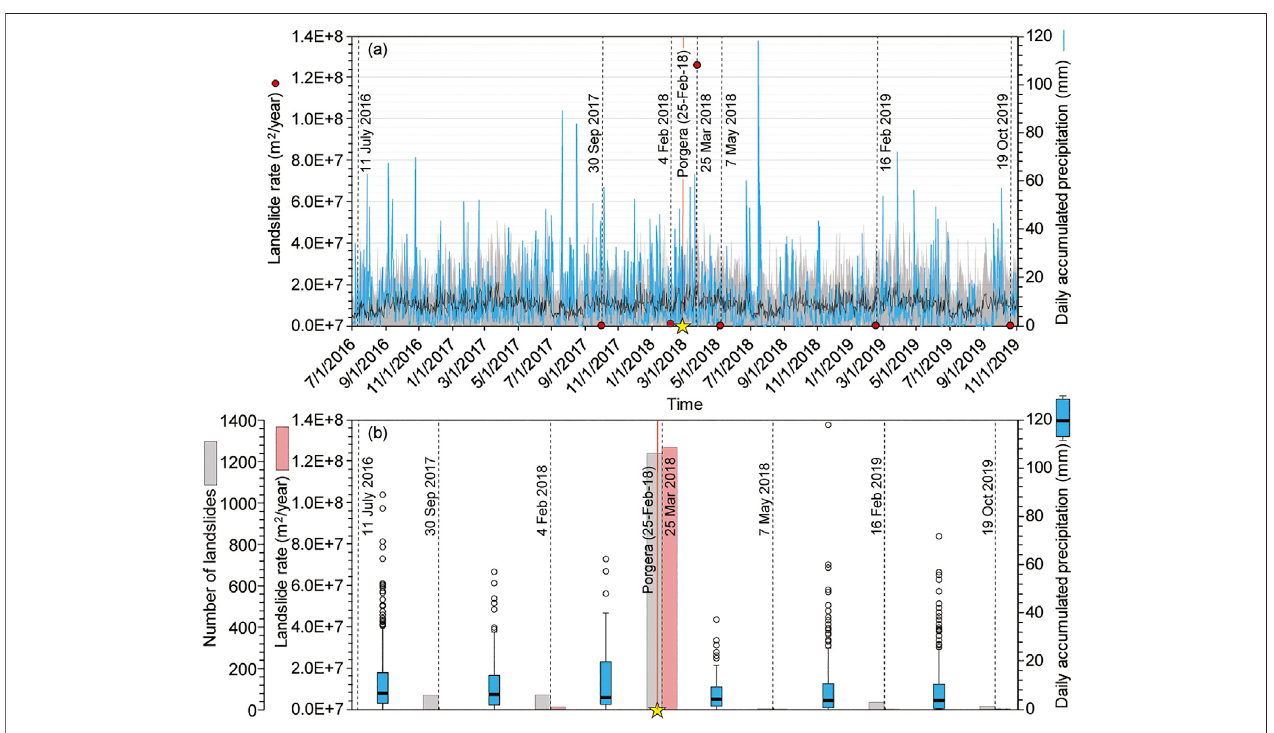
FIGURE 6 | Landslide rates, number of landslides and daily precipitation regarding the examined time windows for the 2018 Porgera earthquakes. Yellow stars showthedateoftheearthquake. Verticaldashed blacklinesindicatethedatesofthesatelliteimageryusedformapping.In PanelA ,themeanandstandarddeviationof daily accumulated precipitation of the respective time windows are calculated from a 20-years time series are shown by black and gray lines, respectively. In Panel B , boxplots show minimum, median and maximum precipitation amounts as well as fi rst, third quartiles and outliers.